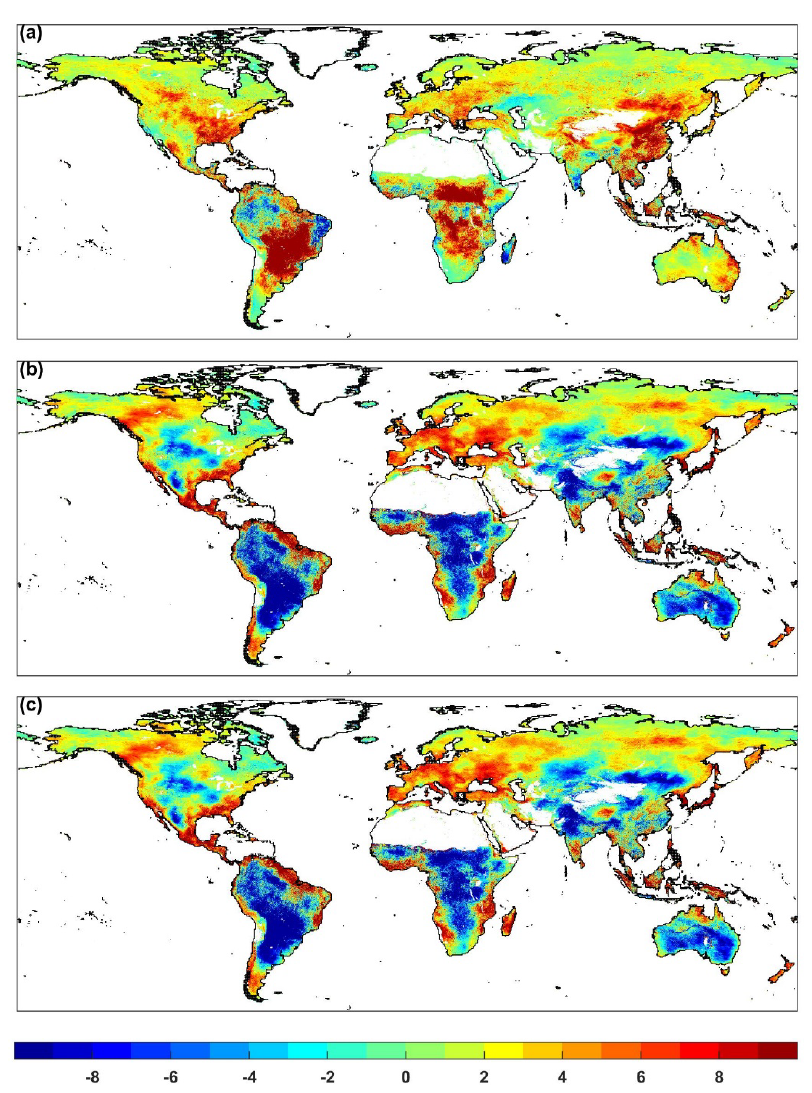
Figure 2. The trend of ( a ) actual ET, ( b ) potential ET, and ( c ) precipitation; from 2001 to 2018 (mm/year).